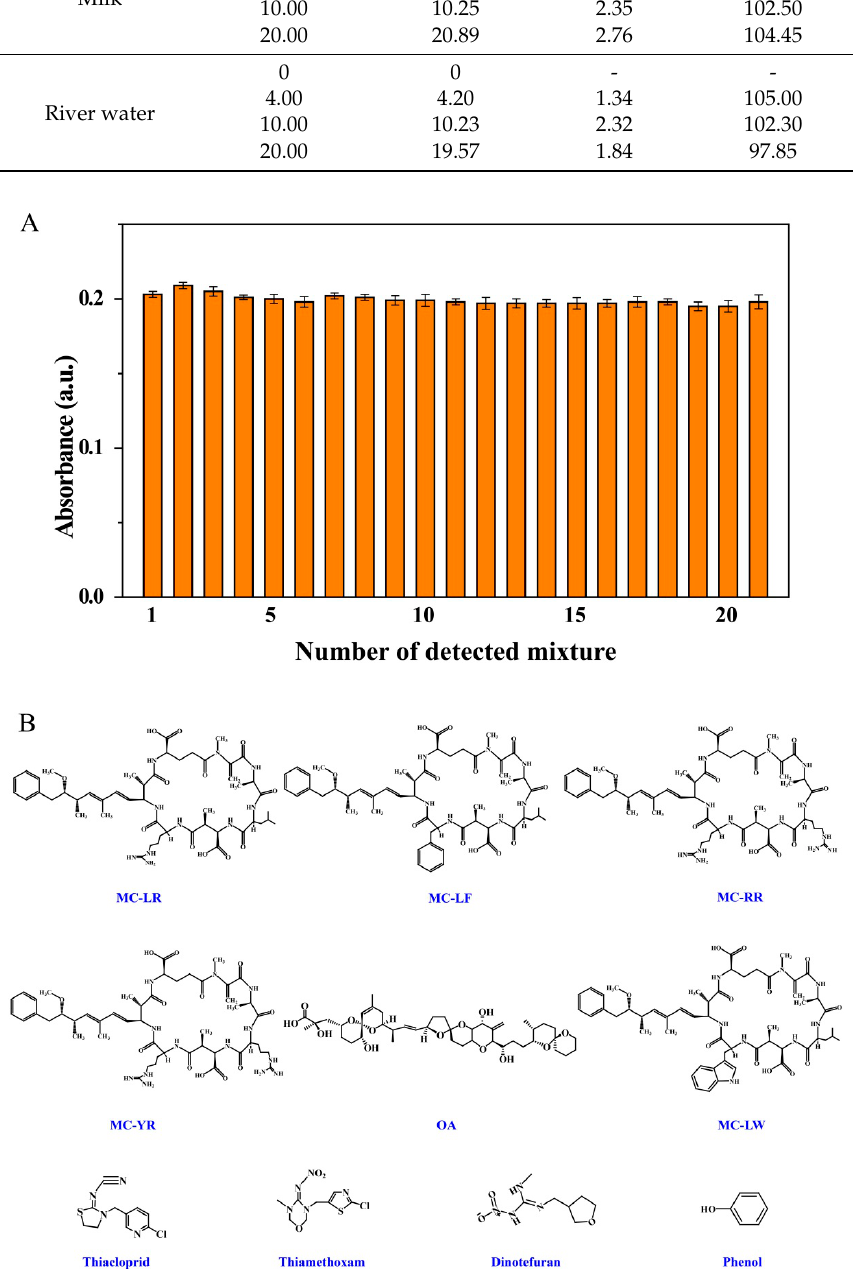
Figure 5. Effects of coexisting substances on colorimetric response of MC-LR. Solution composition: ( A ) (1) 10.0 nM MC-LR in Tris-HCl buffer solution (0.2 M, pH 7.4); mixtures of 10.0 nM MC-LR with (2) MC-LF, (3) MC-RR, (4) MC-YR, (5) OA, (6) MC-LW, (7) K + , (8) Cu 2+ , (9) Ag + , (10) Ca 2+ , (11) Na + , (12) Co 2+ , (13) Mg 2+ , (14) Al 3+ , (15) Fe 3+ , (16) Cd 2+ , (17) thiacloprid, (18) thiamethoxam, (19) dinotefuran and (20) phenol; (21) mixture of 1 with the other 20 types of interferent. ( B ) Molecular structures of